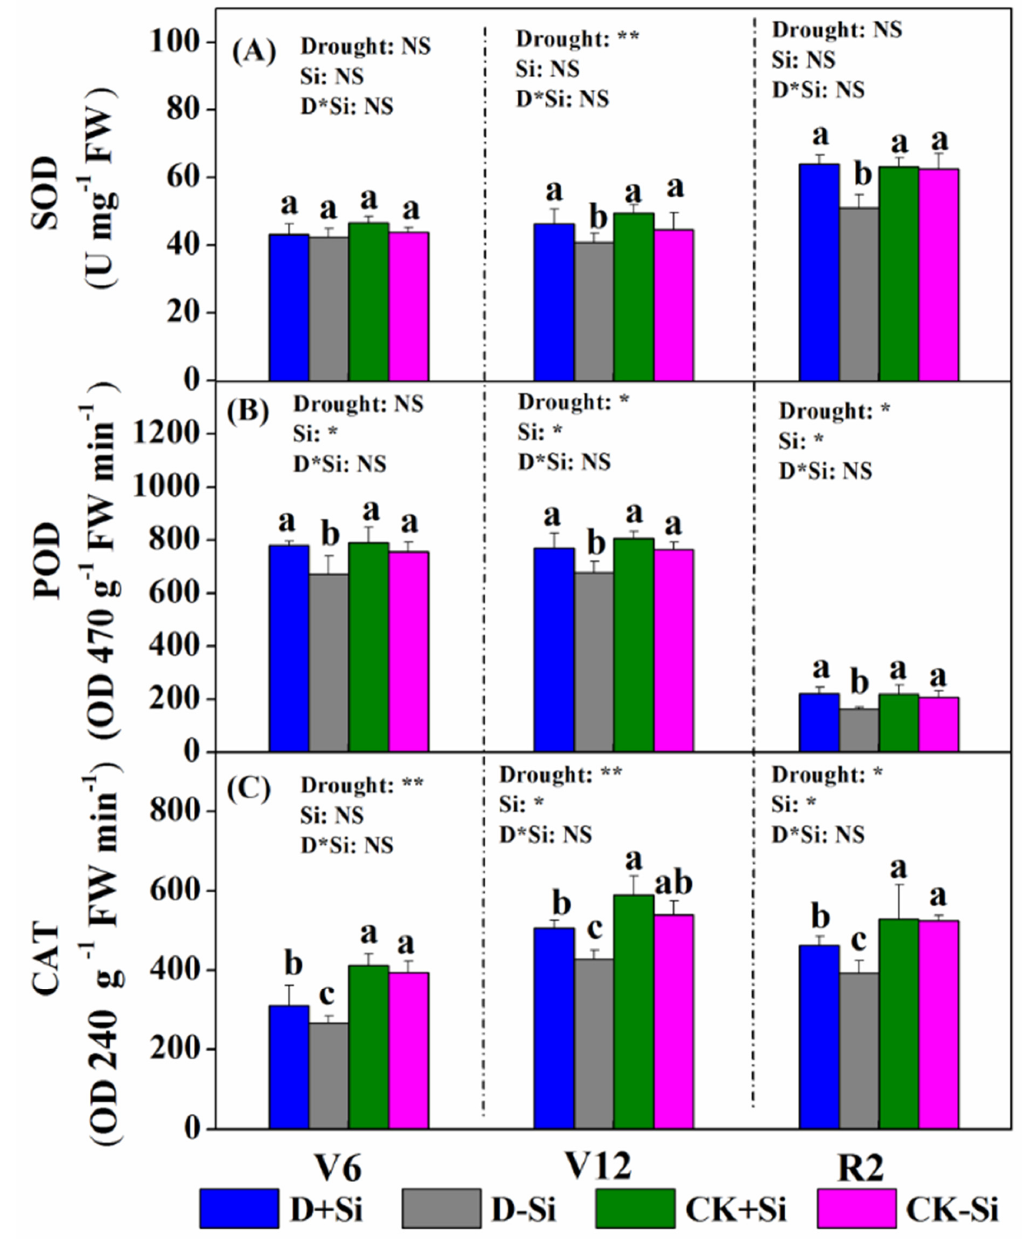
Figure 7. E ff ect of Si application on SOD ( A ), POD ( B ), and CAT ( C ) activities in the maize leaves at the V6, V12, and R2 stages under drought and control conditions. V6, the 6-leaf stage; V12, the 12-leaf stage; R2, the blister stage; + Si, Si addition; -Si, no Si addition; D, drought stress; CK, well-watered control condition. Data are the means ± standard errors (SE) of three replicates, where n = 3 for SOD, POD, and CAT. Di ff erent letters (a, b, c) above the bars indicate statistical significance ( p ≤ 0.05). ** Significant at p ≤ 0.01; * significant at p ≤ 0.05; NS, no significant di ff